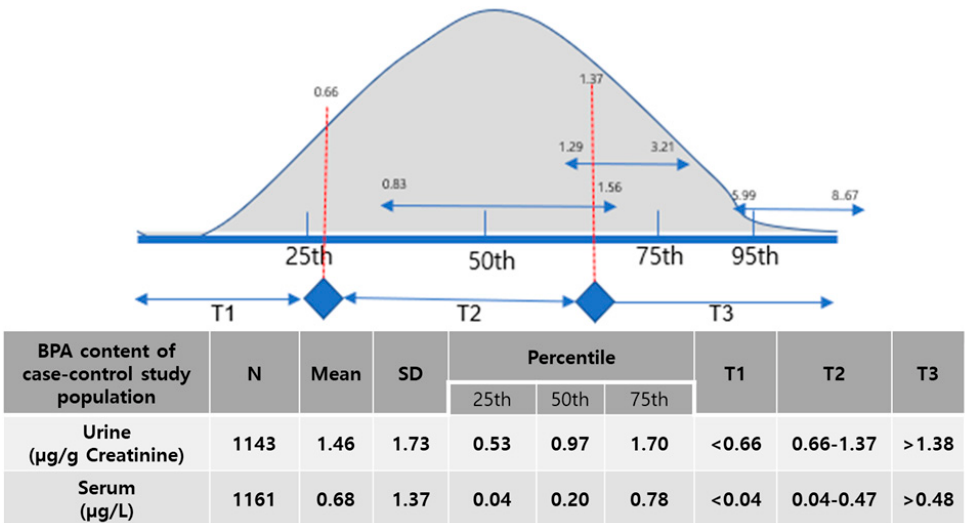
Figure 2. Distribution of urinary bisphenol A level (µg/g creatinine) in the general population from the 2009–2020 National Survey of Korea (upper figure) and the urinary BPA levels for the case-control study population (lower table). The percentile of urinary BPA levels in the general population is expressed as a range from cycle 1 to cycle 4 of the survey [63]. The red lines in the upper figure represent the 25th and 75th percentiles of BPA levels in the case-control study population, respectively.